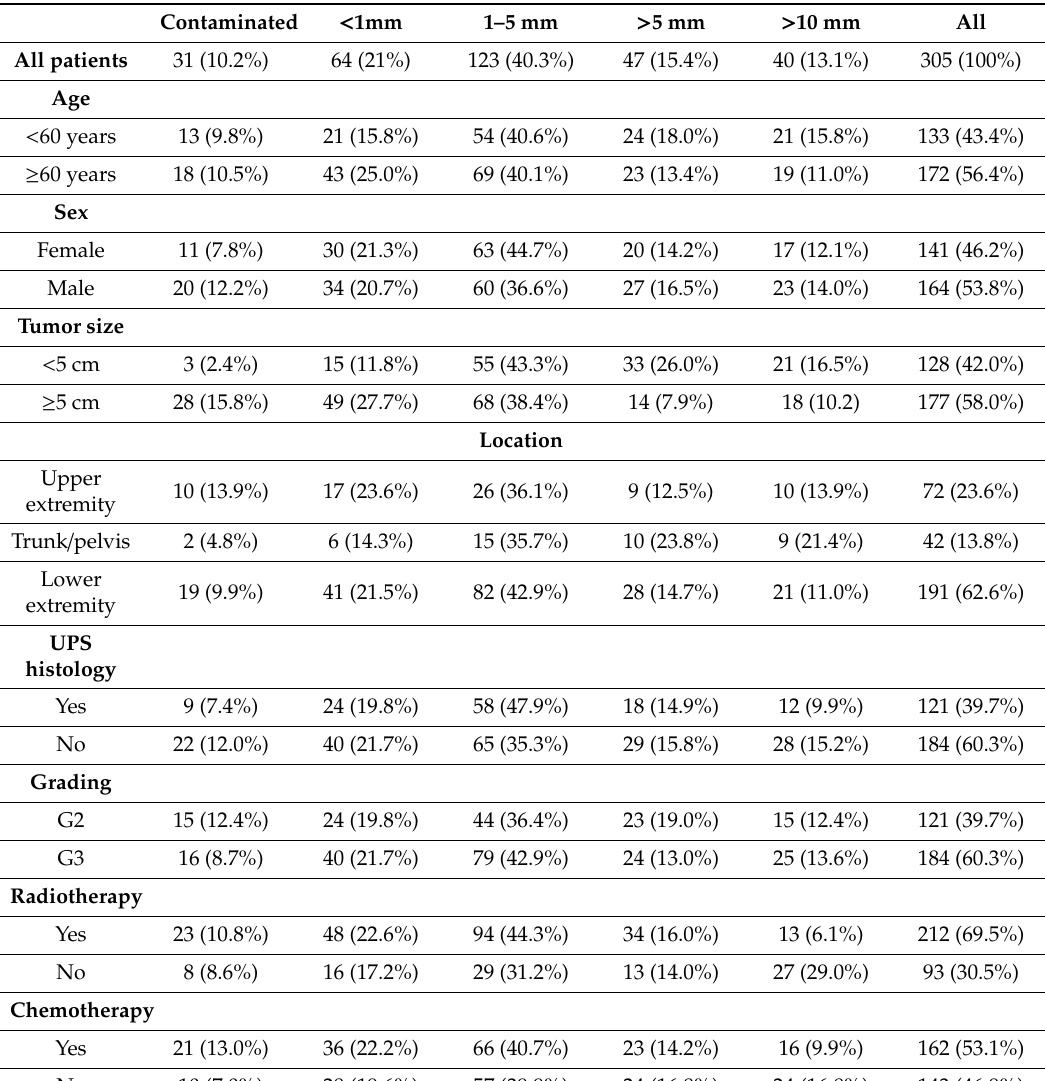
Table 3. Comparison of clinical factors in 305 patients with soft tissue sarcoma in respect to detailed resection